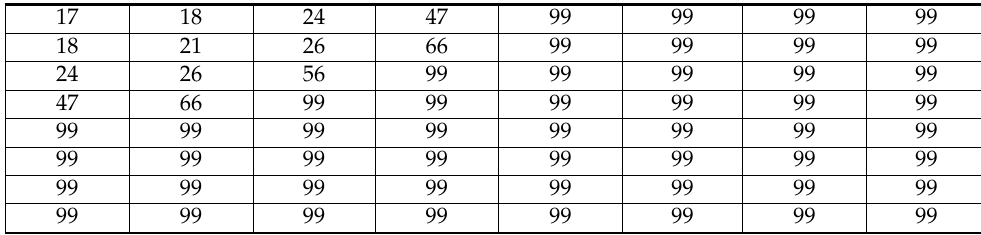
Table 2. The IJG standard chrominance quantization table.